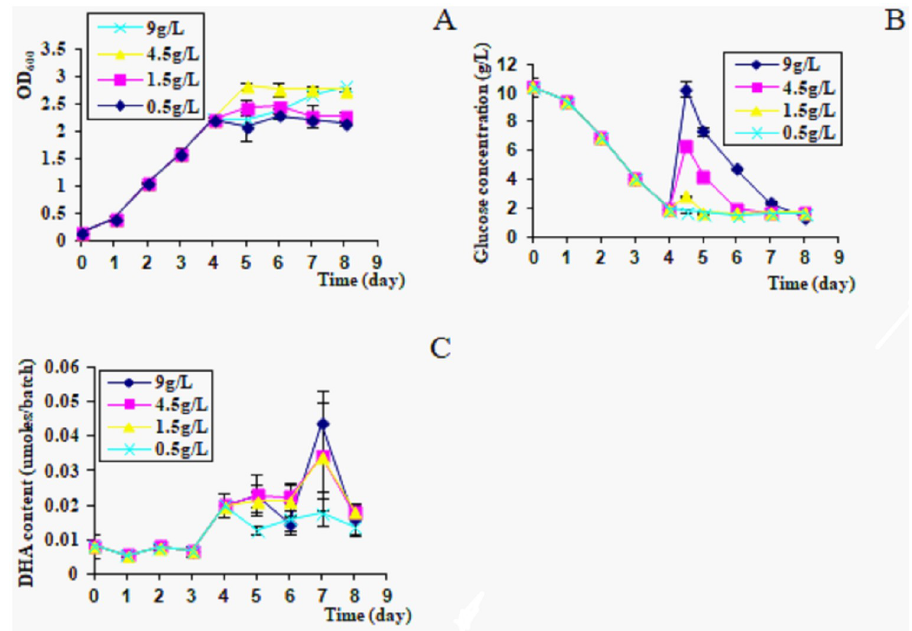
Fig 5. Growth rates and DHA productions with adding additional glucose. A, OD 600 ; B, glucose consumption; C, DHA content in culture, 300 μ